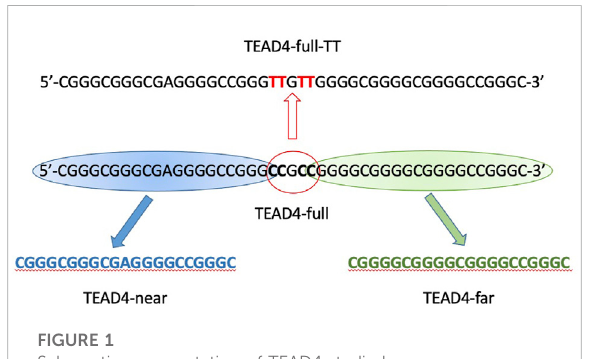
Schematic representation of TEAD4 studied